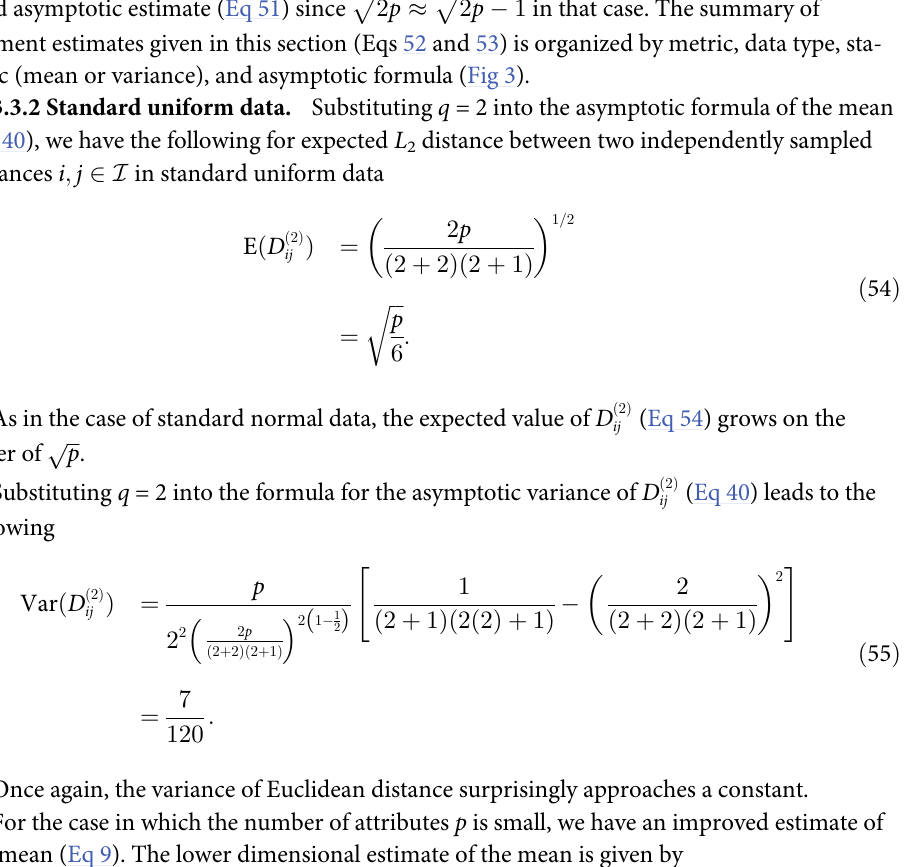
in that case. The summary